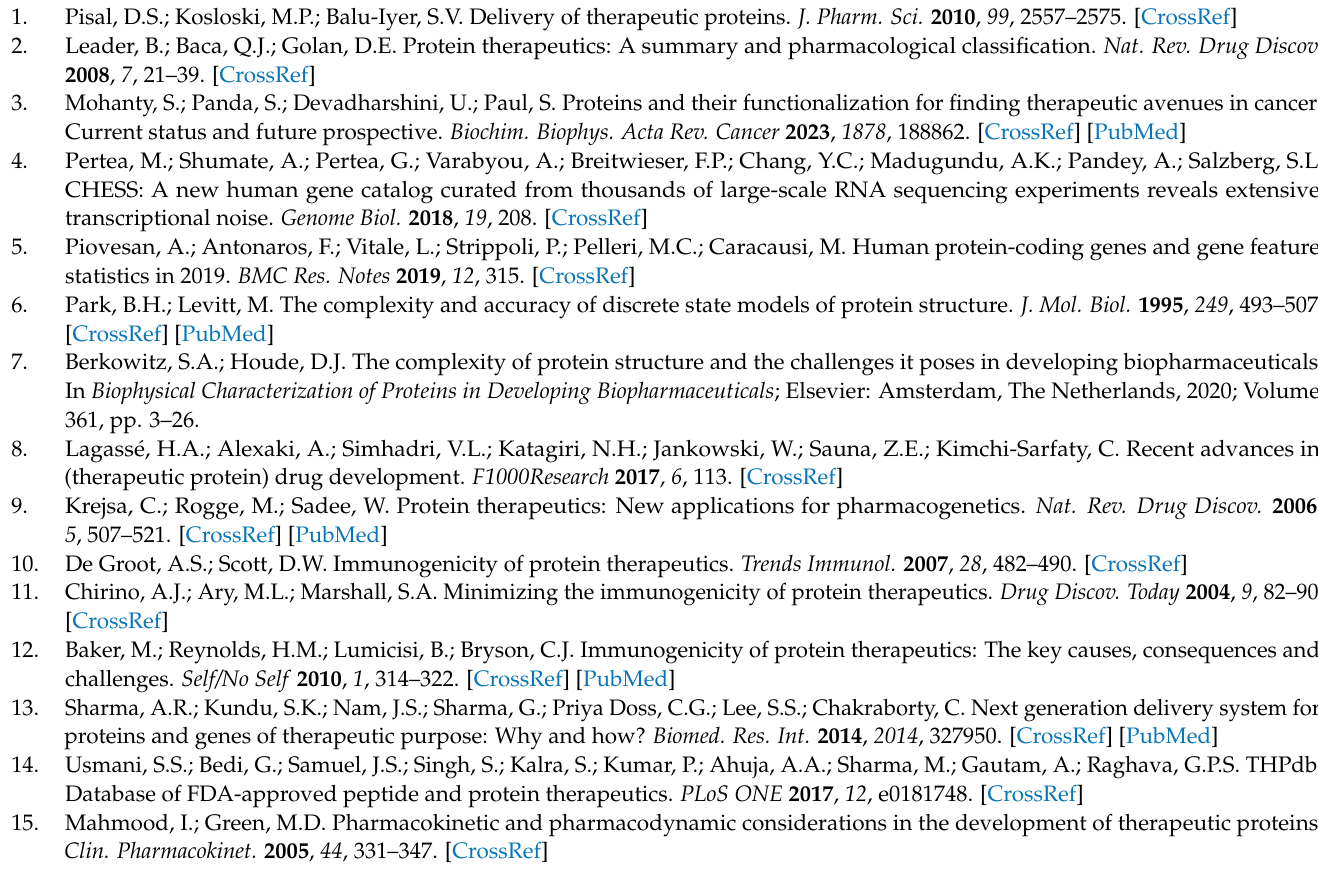
at (50 nM) for 3 h; Figure S7. Confocal microscopy images of MDA-MB-231 cells incubated with GFP-[(RW) 5 K](RW) 5 mixture at a peptide concentration range (1–5 µ M) and GFP at (50 nM) for 3 h; Figure S8. Confocal microscopy images of MDA-MB-231 cells incubated with GFP-[WWRR] 4 mixture at a peptide concentration range (1–6 µ M) and GFP at (50 nM) for 3 h; Figure S9. Confocal microscopy images of MDA-MB-231 cells incubated with GFP-[WWRR] 5 mixture at a peptide concentration range (1–5 µ M) and GFP at (50 nM) for 3 h; Figure S10. Improved delivery of RFP (50 nM) by F (cid:48) -[DipR]5 in MDA-MB-231 cells; Figure S11. Cellular uptake study of GFP (50 nM) with [WR] 9 in the presence of endocytosis inhibitors in MDA-MB-231 cells after 3 h incubation; Figure S12. Cellular uptake study of GFP (50 nM) with [DipR] 5 in the presence of endocytosis inhibitors in MDA-MB-231 cells after 3 h